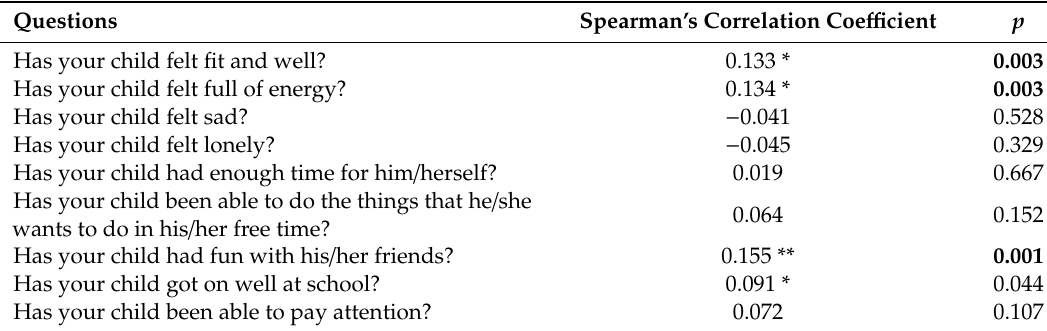
Table 6. Correlation table between the PA variable (physical activity frequency) and each of the items of the Kidscreen-10 Index modified for the